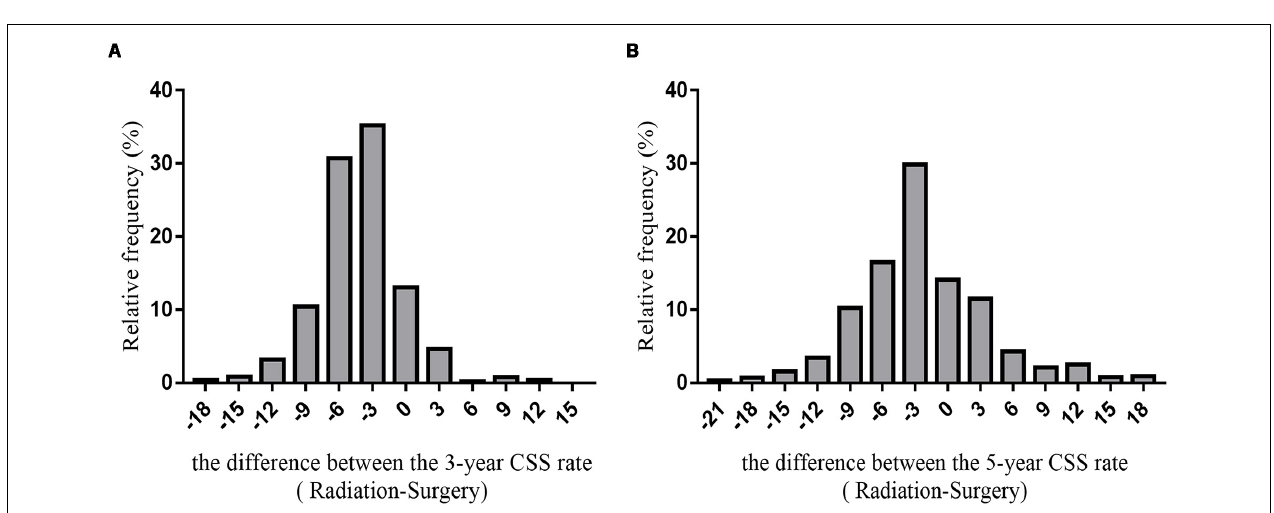
FIGURE 5 | The histogram of the difference between CSS rates (radiotherapy-surgery) (A) the difference between 3-year CSS rates (B) the difference between 5-year CSS rates.